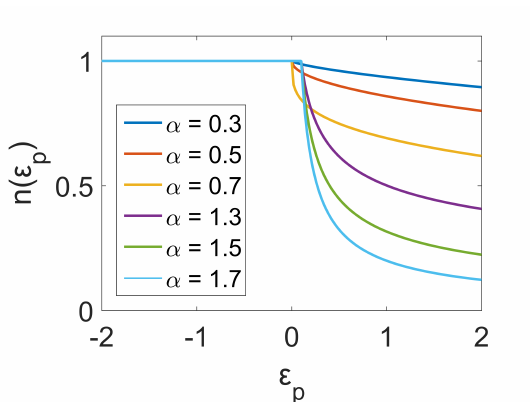
Figure 2: A plot of the occupation number n ( p ) of fermions with power-law Green functions. The parameters used here are E = 50, and δ =